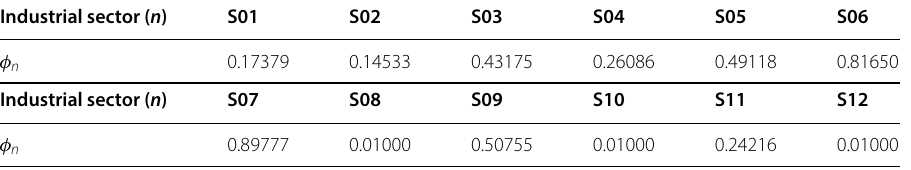
S01–S12 are the identifying numbers indicating industrial sectors shown in Table 1